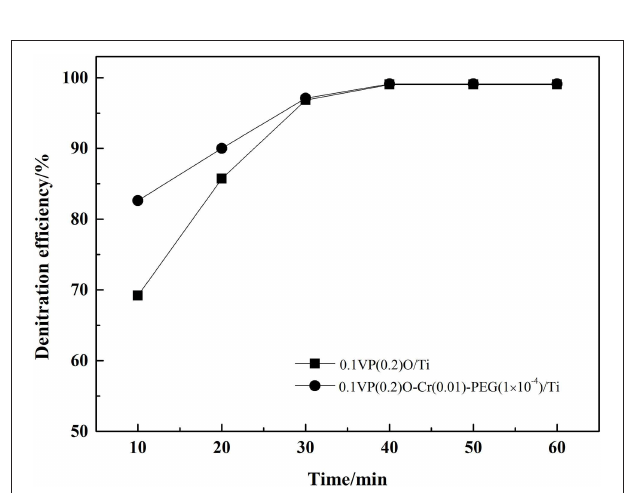
FIGURE 8 | Denitration efficiency of catalyst after remove SO 2 and water vapor in feed